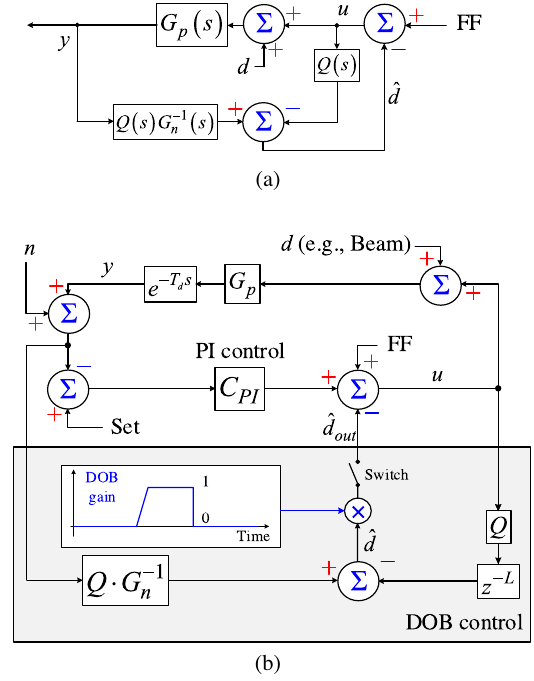
FIG. 12. (a): Basic structure of DOB control. The disturbance signal d can be estimated by the DOB controller output effective bandwidth of the controller is determined by the low- pass Q filter. (b): Simplified architecture of DOB control in combination with PI